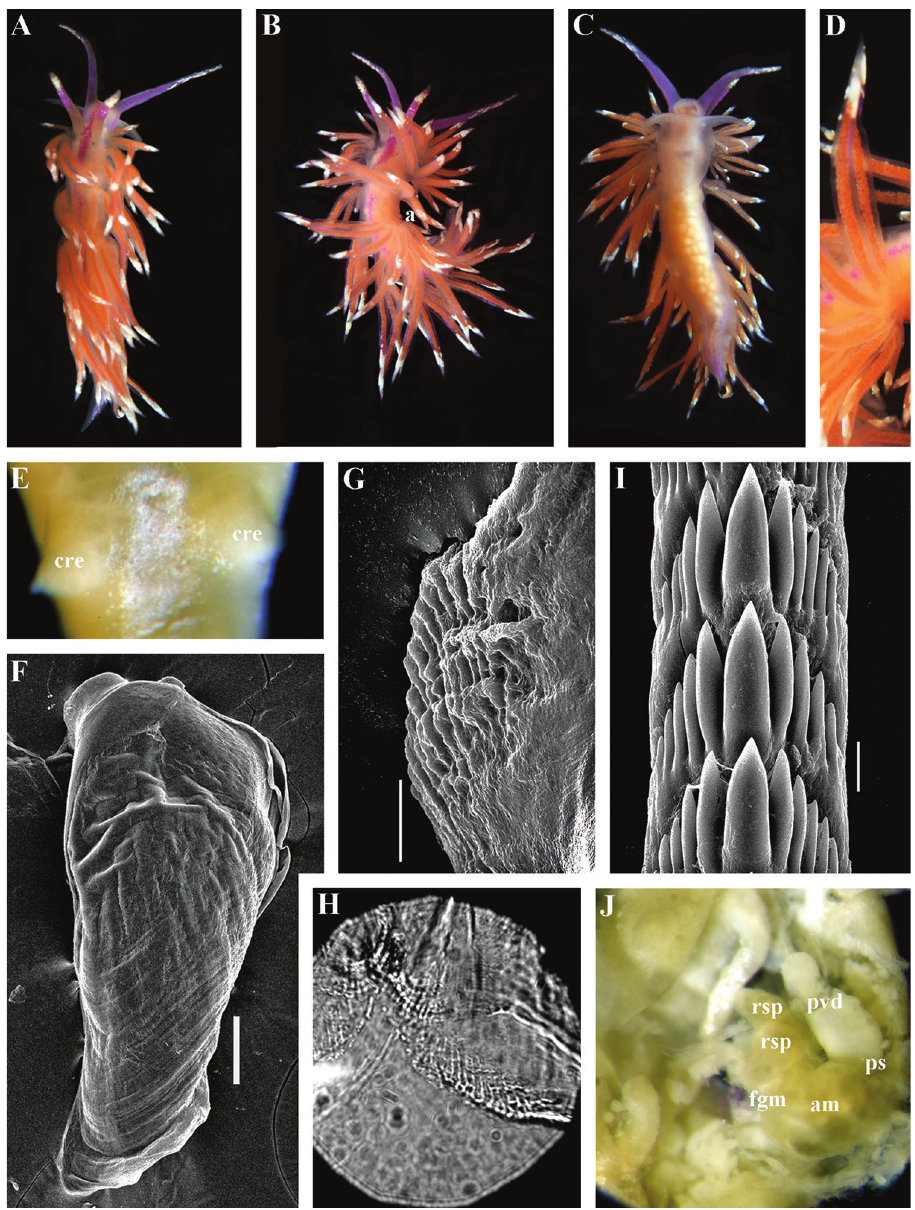
Figure 42. Unidentia nihonrossija sp. n. Japan, Pacific Honshu, Osezaki. ZMMU Op-517, specimen 4.5 mm in length (fixed): A dorsal view (live) B lateral view (live) C ventral view (live) D details of cerata (live) E particular elongate elevations at the base of cerata (fixed) F jaw, SEM G details of masticatory pro- cess of jaw, SEM H details of masticatory process of jaw, light microscopy I radular teeth, posterior part, SEM J reproductive system, light microscopy. Abbreviations: a anus am ampulla cre ceratal elevated rows fgm female gland mass ps penial sheath pvd prostatic vas deferens rsp proximal receptaculum sem- inis. Scale bars: F = 100 μm; G, I = 10 μm. Photos and SEM images by T.A. Korshunova, A.V.